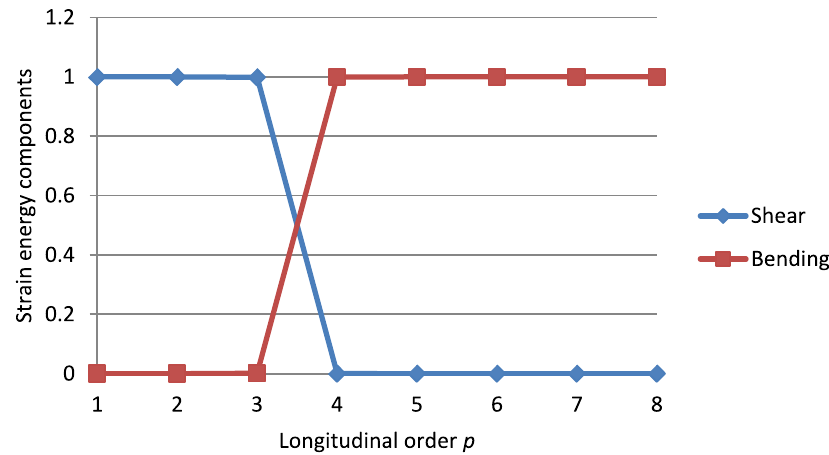
Figure 3. The sum of local energies—the bending-dominated